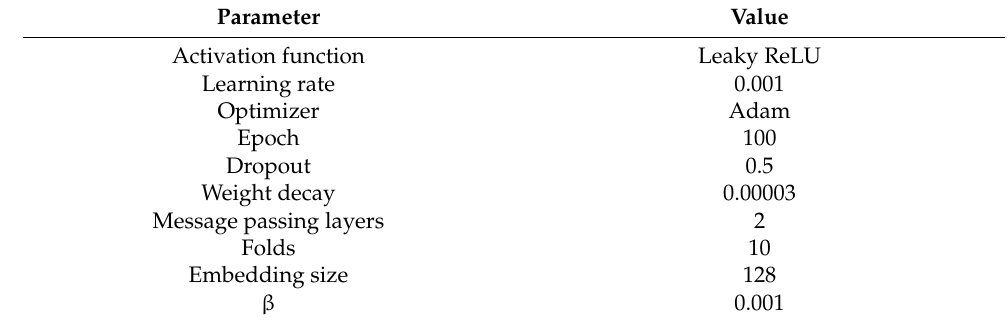
Table 4. Bot-MGAT parameters.